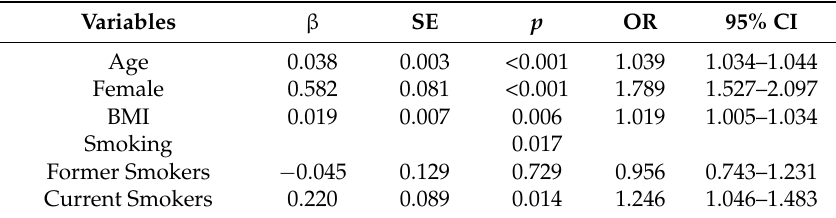
Table 5. Logistic regression analysis with possible risk factors as independent variables and the prevalence of thyroid nodules as a dependent variable. Variables β SE p OR 95% CI Age 0.038 0.003 <0.001 1.039 1.034–1.044 Female 0.582 0.081 <0.001